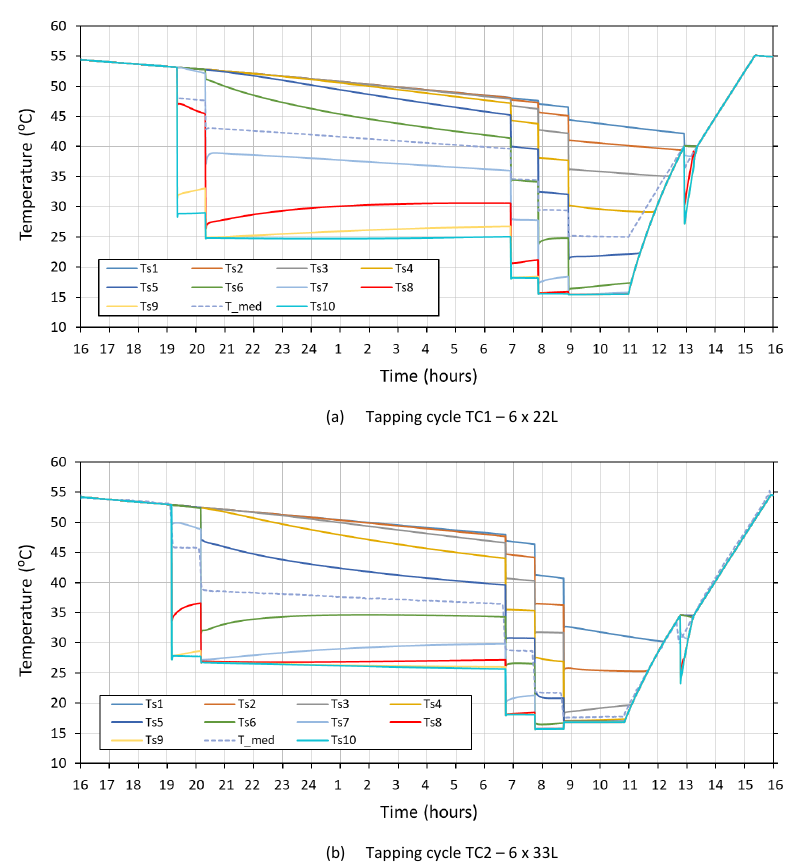
Figure 7. Water tank thermal stratification. Numerical results of the tank wall temperatures along the vertical axis (top: T s ,1 , bottom: T s ,10